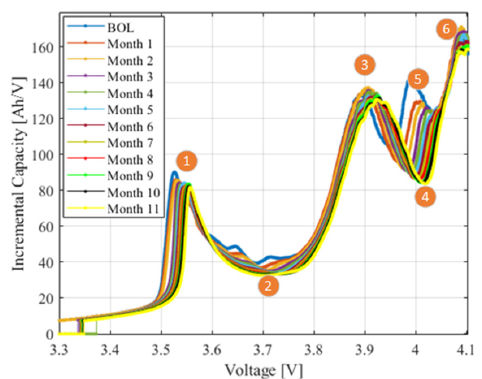
Figure 8. Evolution of the ICA curve during calendar aging of an NMC ‐ based Li ‐ ion battery with numbered peak and valley zones (adapted from [21]).